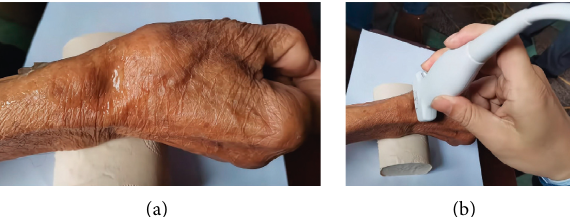
Figure 1: The study